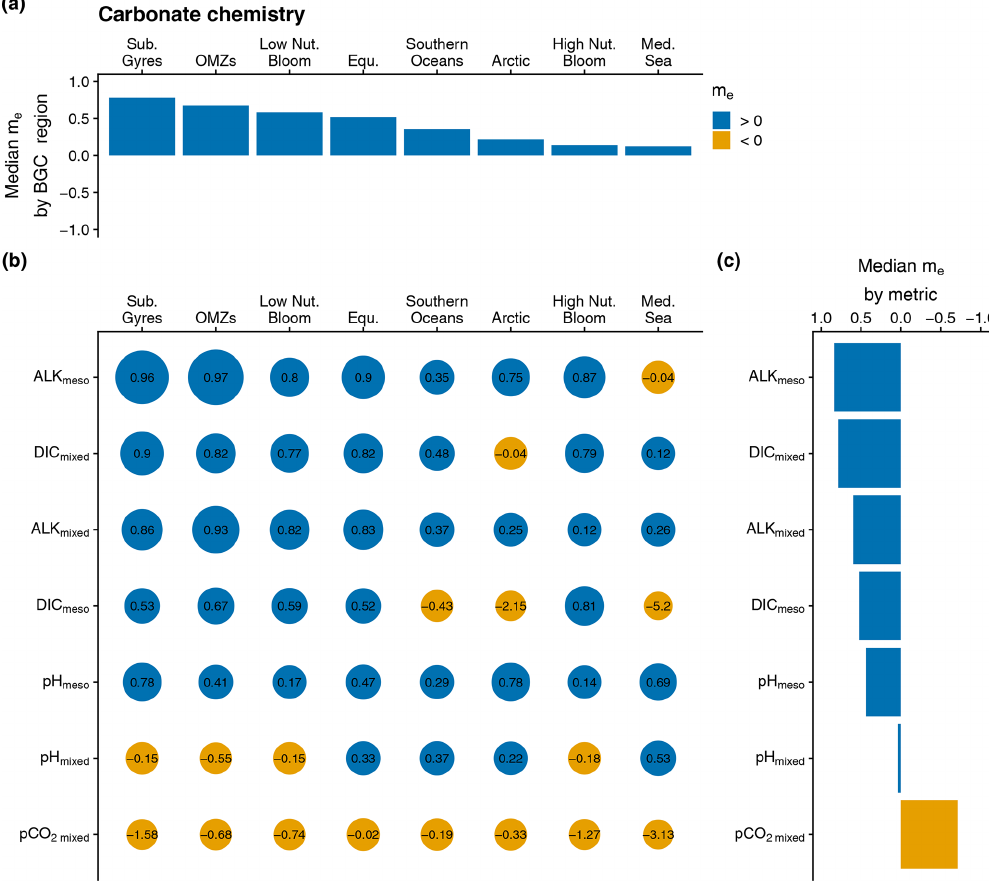
Figure 3. (b) Bubble plot of the model efficiency statistical score ( m e ) as a function of BGC regions (Arctic, equatorial (Equ.), high nutrient bloom (High Nut. Bloom), low nutrient bloom (Low Nut. Bloom), Mediterranean Sea (Med. Sea), oxygen minimum zones (OMZs), Southern Oceans, and subtropical gyres (Sub. Gyres)) and the assessment metrics associated with the carbonate chemistry (depth-averaged p CO 2 in the mixed layer ( p CO 2mixed ) , depth-averaged DIC in the mixed layer (DIC mixed ) , depth-averaged Alk in the mixed layer (Alk mixed ) , depth- averaged DIC in the mesopelagic layer (DIC meso ) , depth-averaged Alk in the mesopelagic layer (Alk meso ) , depth-averaged pH in the mixed layer (pH mixed ) , and depth-averaged pH in the mesopelagic layer (pH meso ) ). The size of a bubble is proportional to the value of m e . For a given assessment metric, the median values of m e over all BGC regions are represented as a bar plot in panel (c) . Similarly, for a given BGC region, the median values of m e across all assessment metrics are represented as a bar plot in panel (a) . In panel (b) , the x and y axes are arranged in descending order of the median value of m e over all assessment metrics and the median value of m e over all BGC regions, respectively. The blue and orange colors correspond to a positive and negative m e ,